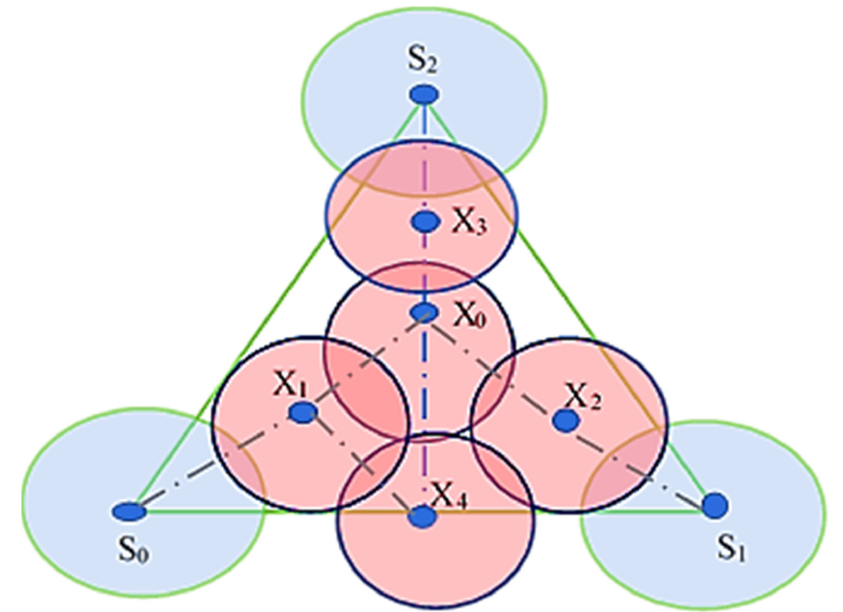
Figure 14. The position of assisted sensors.